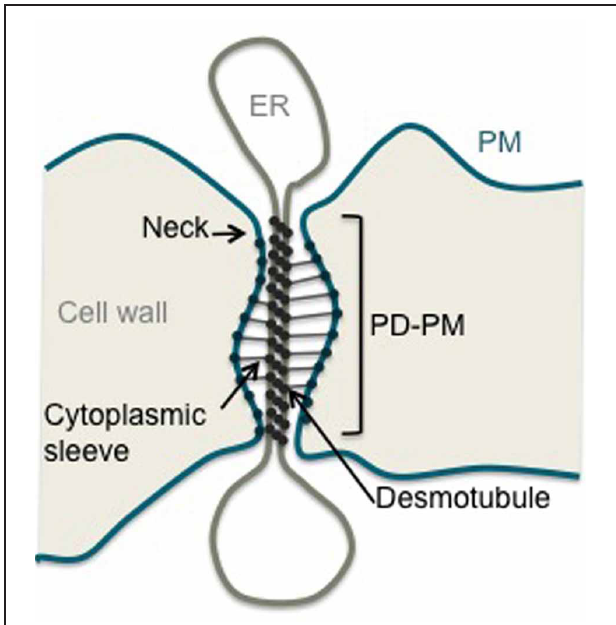
FIGURE 1 | Structure of a plasmodesma. Schematic representation of a simple stranded PD. ER, Endoplasmic Reticulum; PM, Plasma Membrane; PD-PM, Plasma Membrane lining